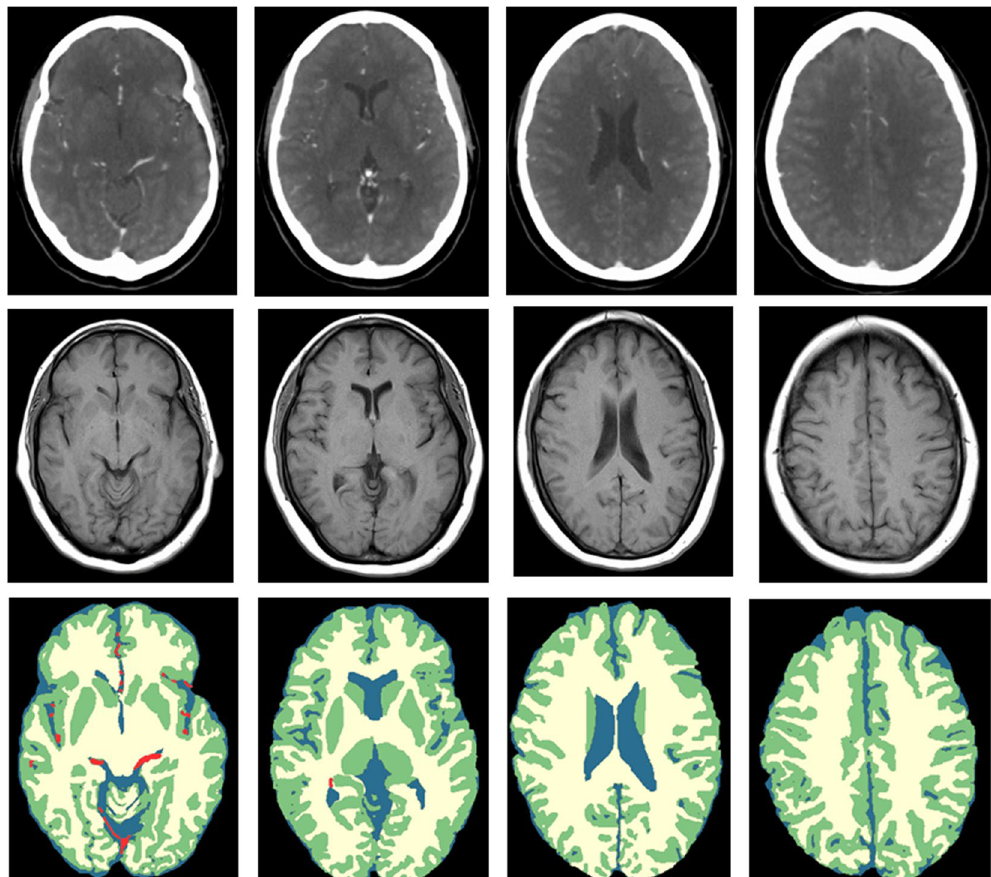
Figure 7. Axial slices at approximately the level of the Circle of Willis, basal ganglia, lateral ventricles and centrum semiovale (from left to right). From top to bottom: WTA (window width/level 300/100 HU); the registered MR T1w image; the final segmentation after manual refinement showing CSF (blue), WM (yellow), GM (green), and blood vessels